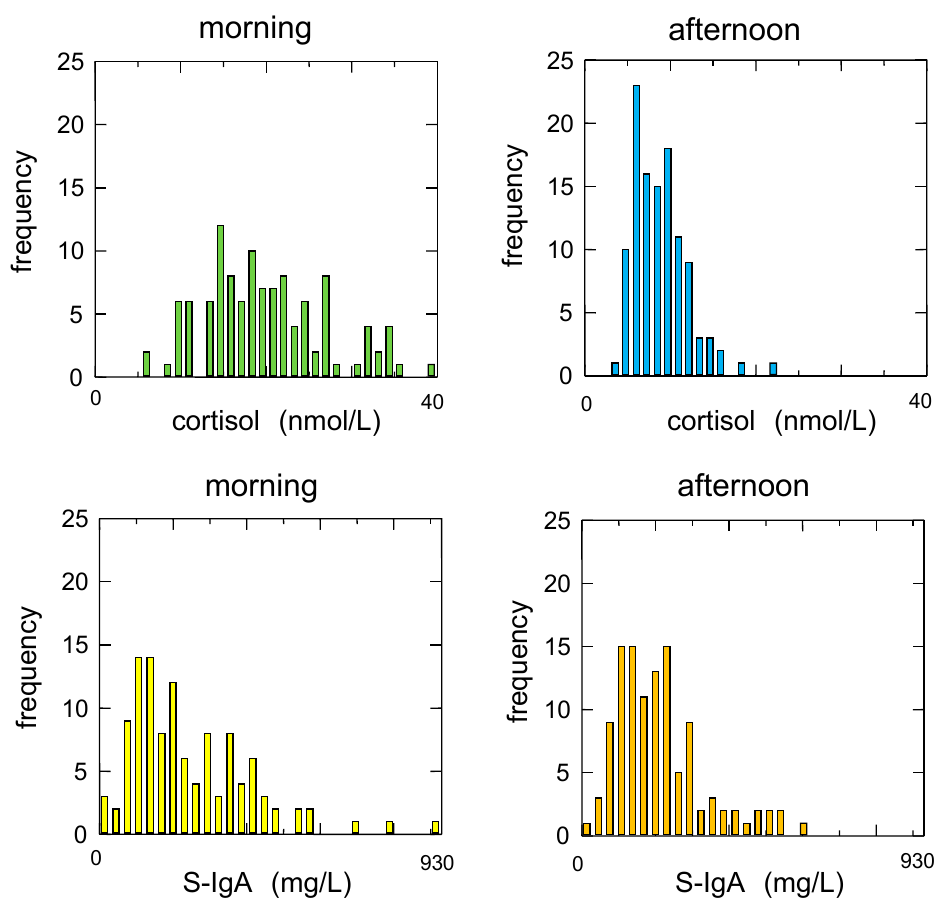
Figure 1. Frequency distributions of salivary cortisol and immunoglobulin A concentrations. Salivary cortisol concentrations showed a more skewed distribution in the afternoon compared to those in the morning (upper panels), whereas the skewness of secretory immunoglobulin A (S-IgA) concentrations did not change from morning to afternoon (lower panels).